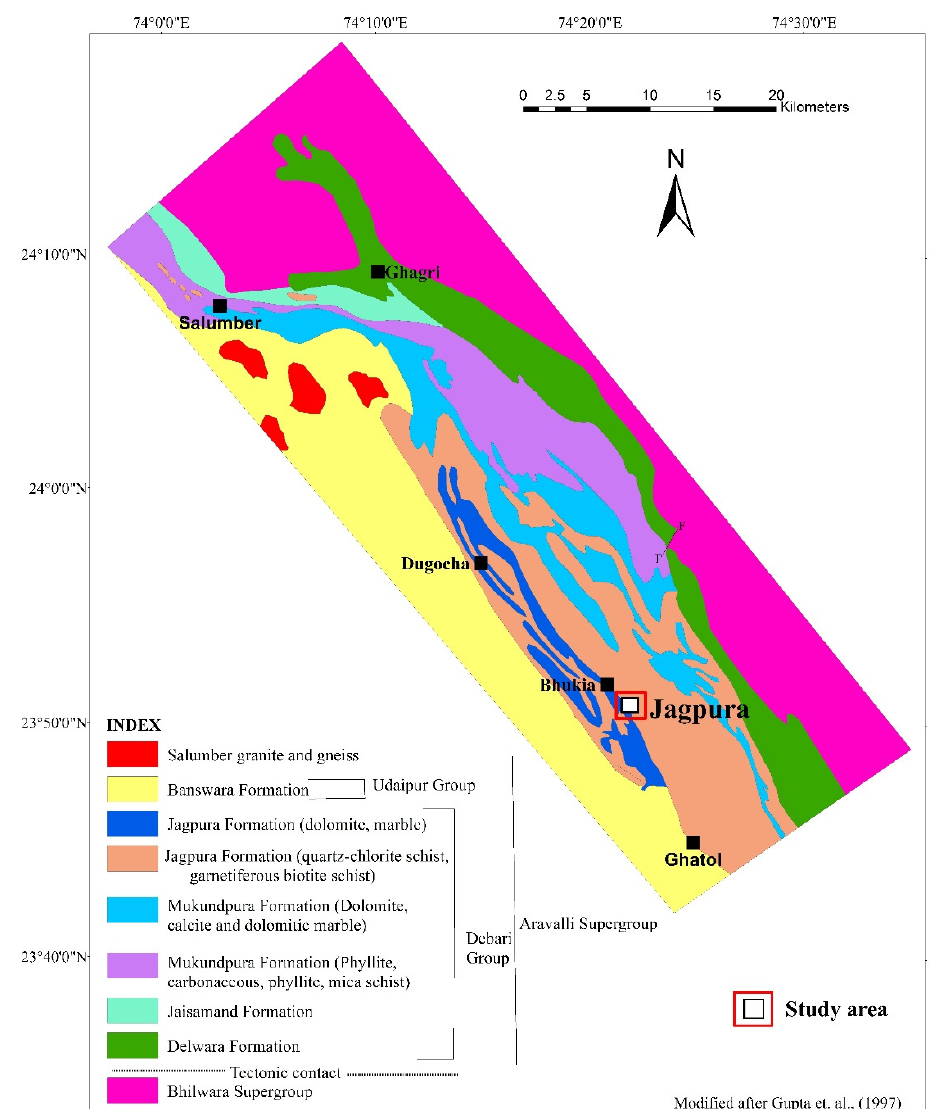
Figure 2. Geological map of Salumber-Ghatol metallogenic belt showing location of study area, modified from reference [51].